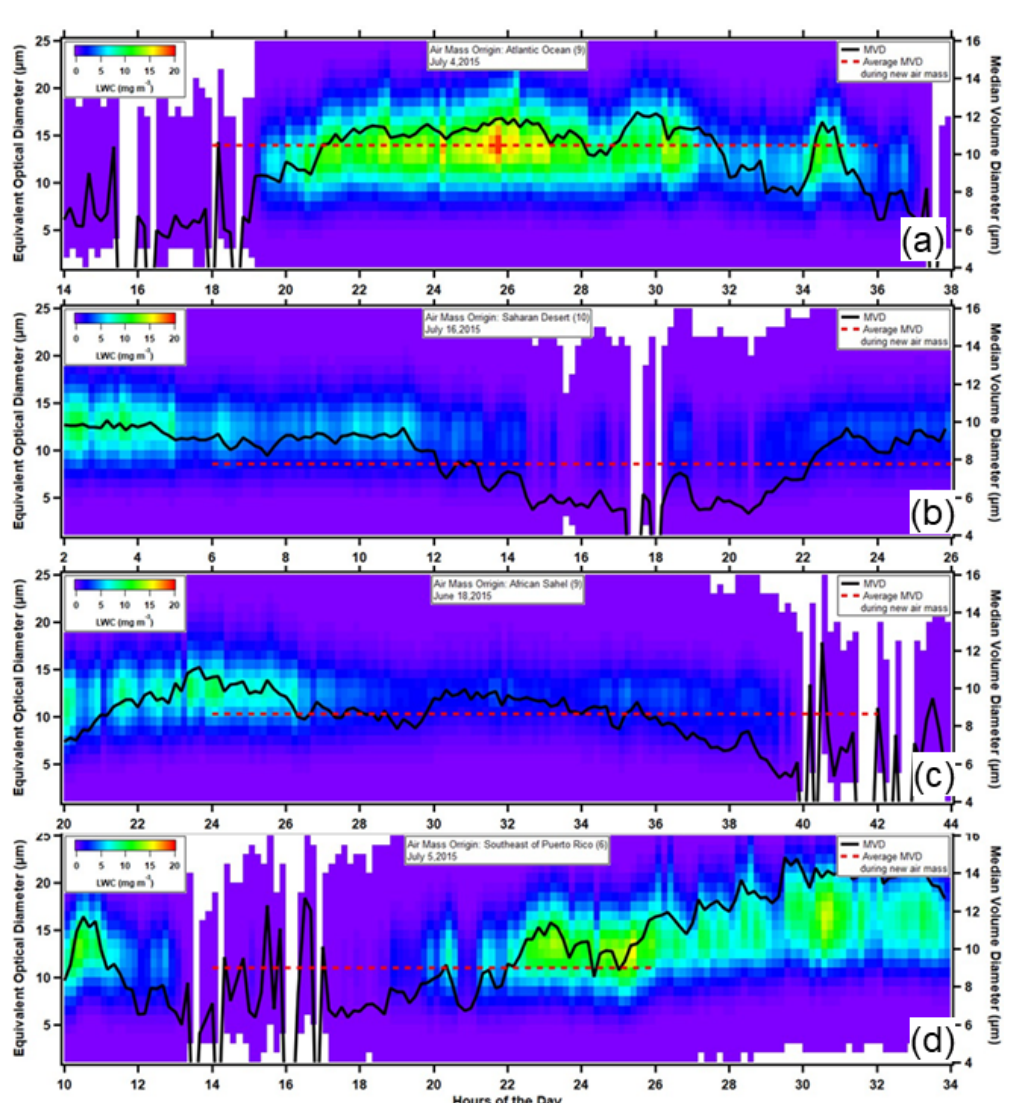
Figure 6. The same as Fig. 5 but for the size distribution of liquid water content (LWC). The color coding designates the value of the LWC (mgm − 3 ). The average median volume diameter (MVD) is drawn as the solid black